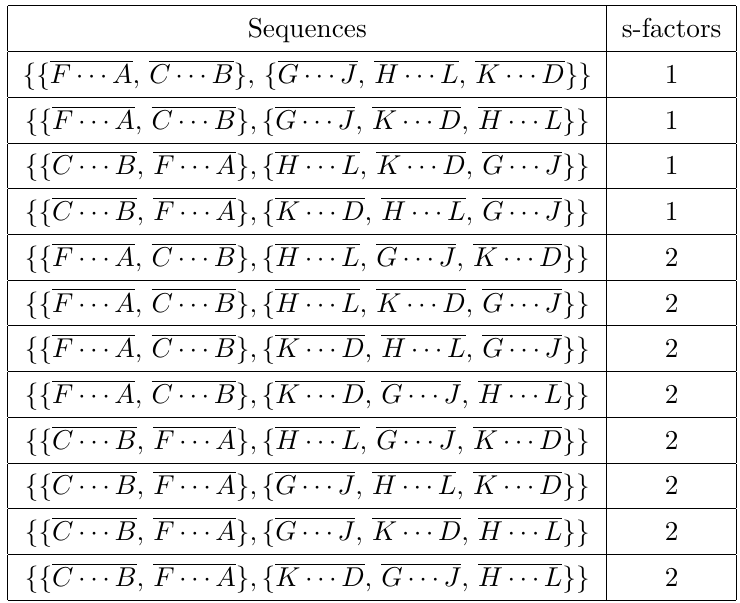
Table 3. Reducible diagrams and their s -factors.